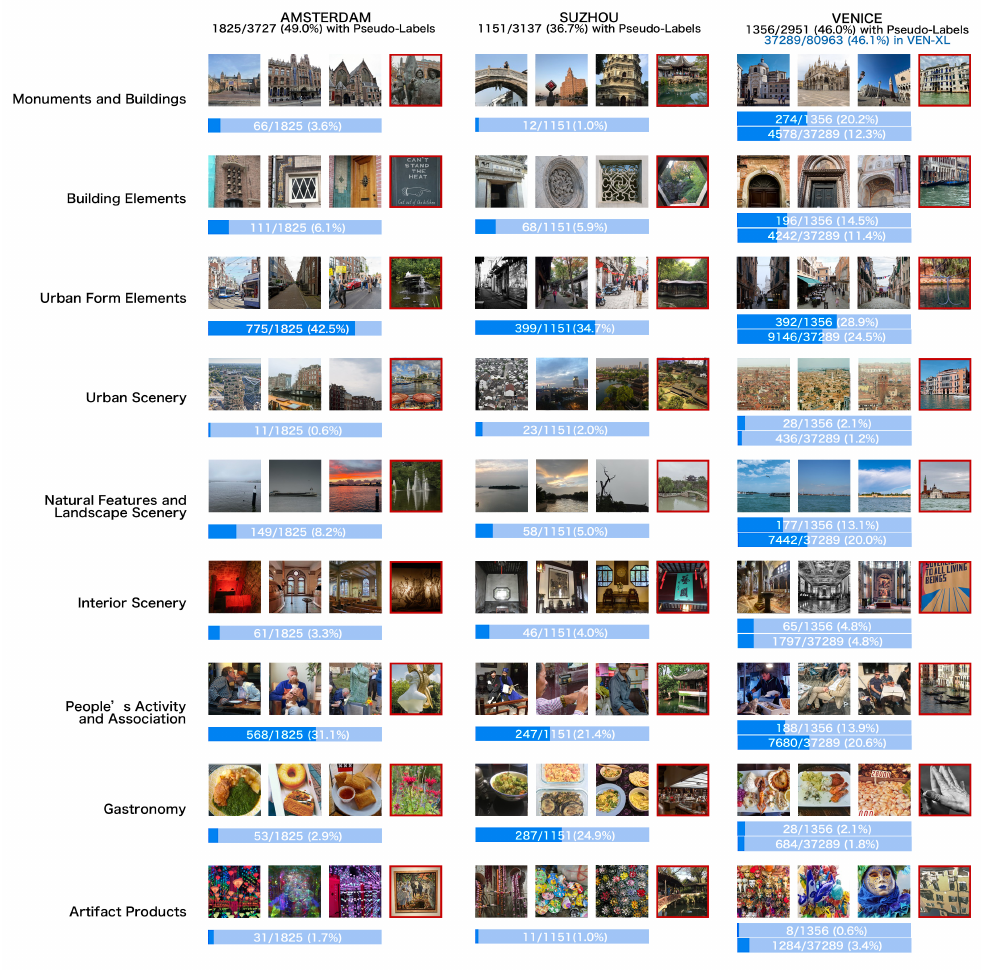
Figure 4. Typical image examples in each city labelled as each heritage attribute category (depicted scene) and bar plots of their proportions in the datasets (length of bright blue background bars represent 50%). Three examples with high confidence and one negative example with low confidence (in red frame) are given. All images are 150 × 150 px “thumbnails” flagged as